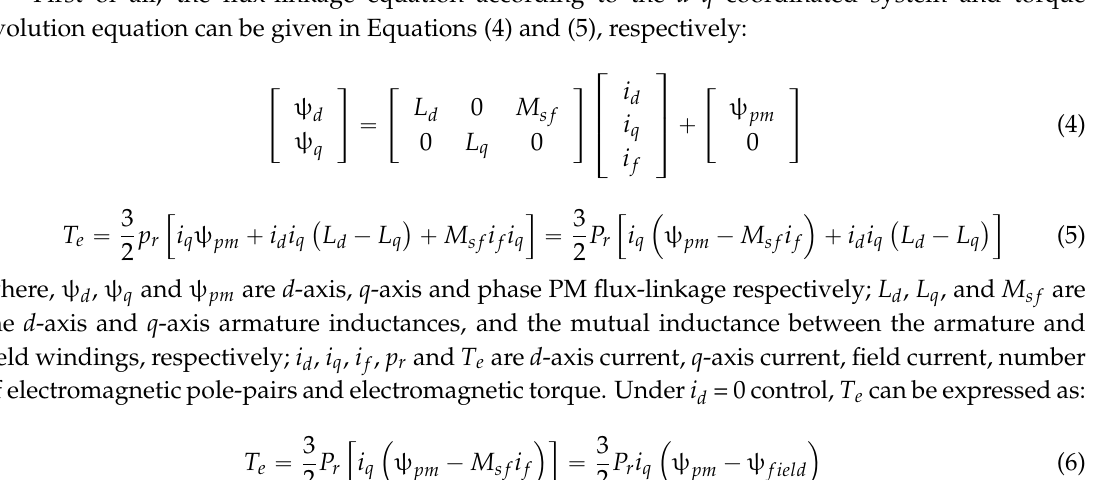
Figure 8. Variation of torque ripple values by different field currents. ( a ) Employing ferrite;